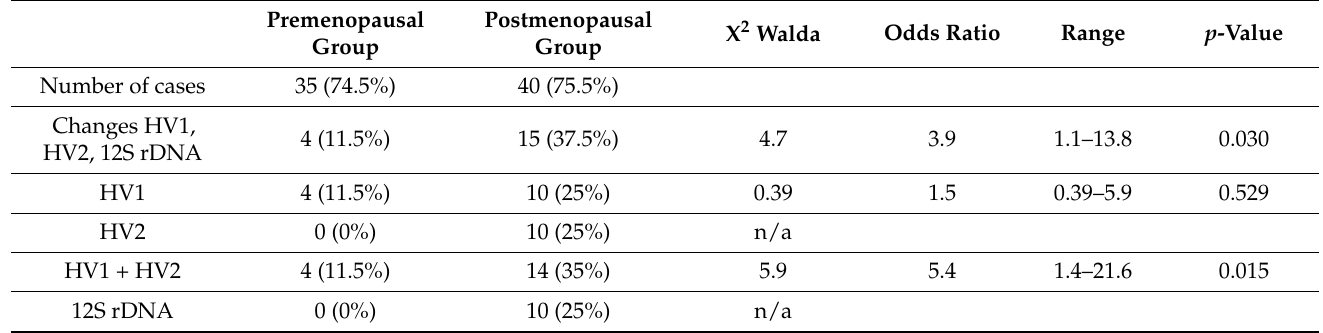
Table 4. The frequency of nucleotide sequence changes in various mtDNA regions in the group of women with arterial hypertension depending on the menopausal